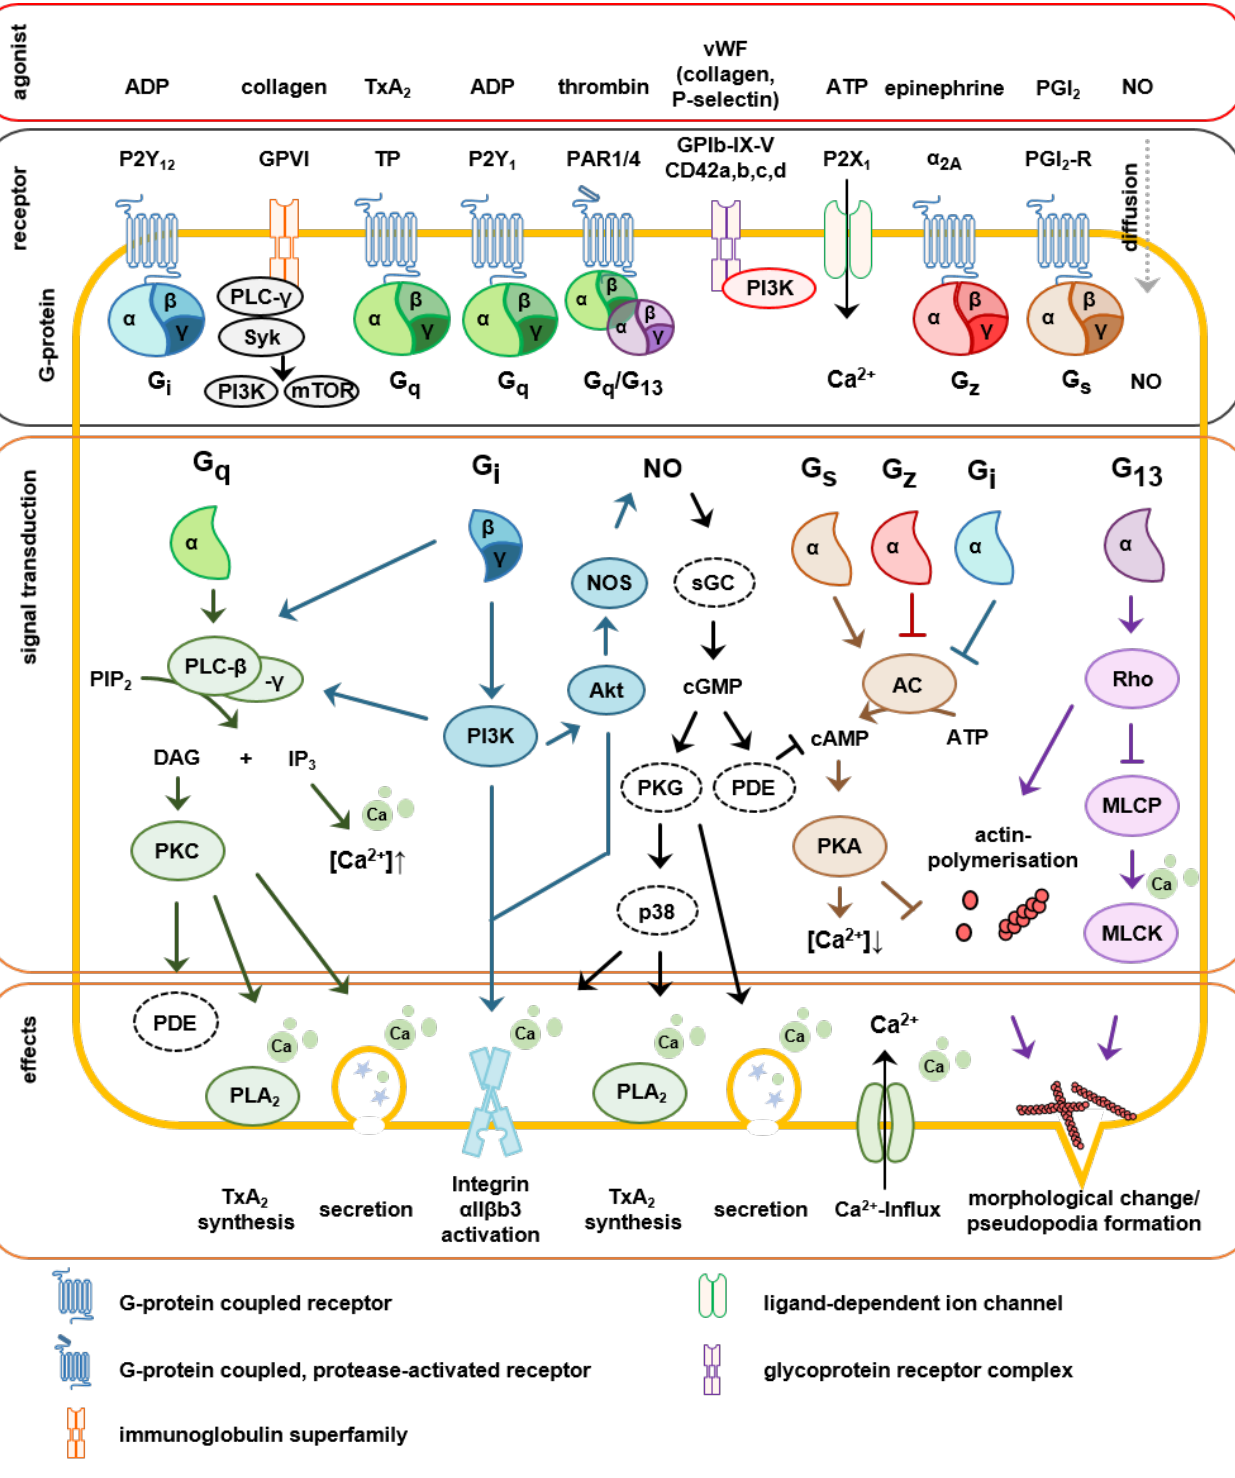
Figure 2. Simplified scheme of signaling involved in platelet activation. Created with motifolio.com (accessed on 1 February 2022).